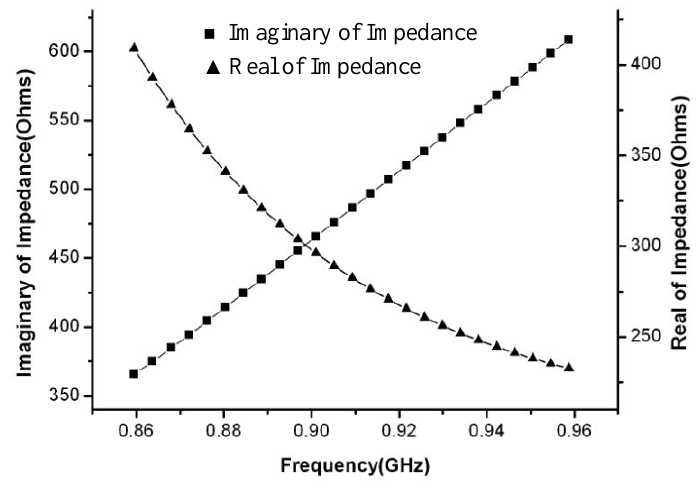
Figure 7. Input impedance of the antenna module versus frequency.